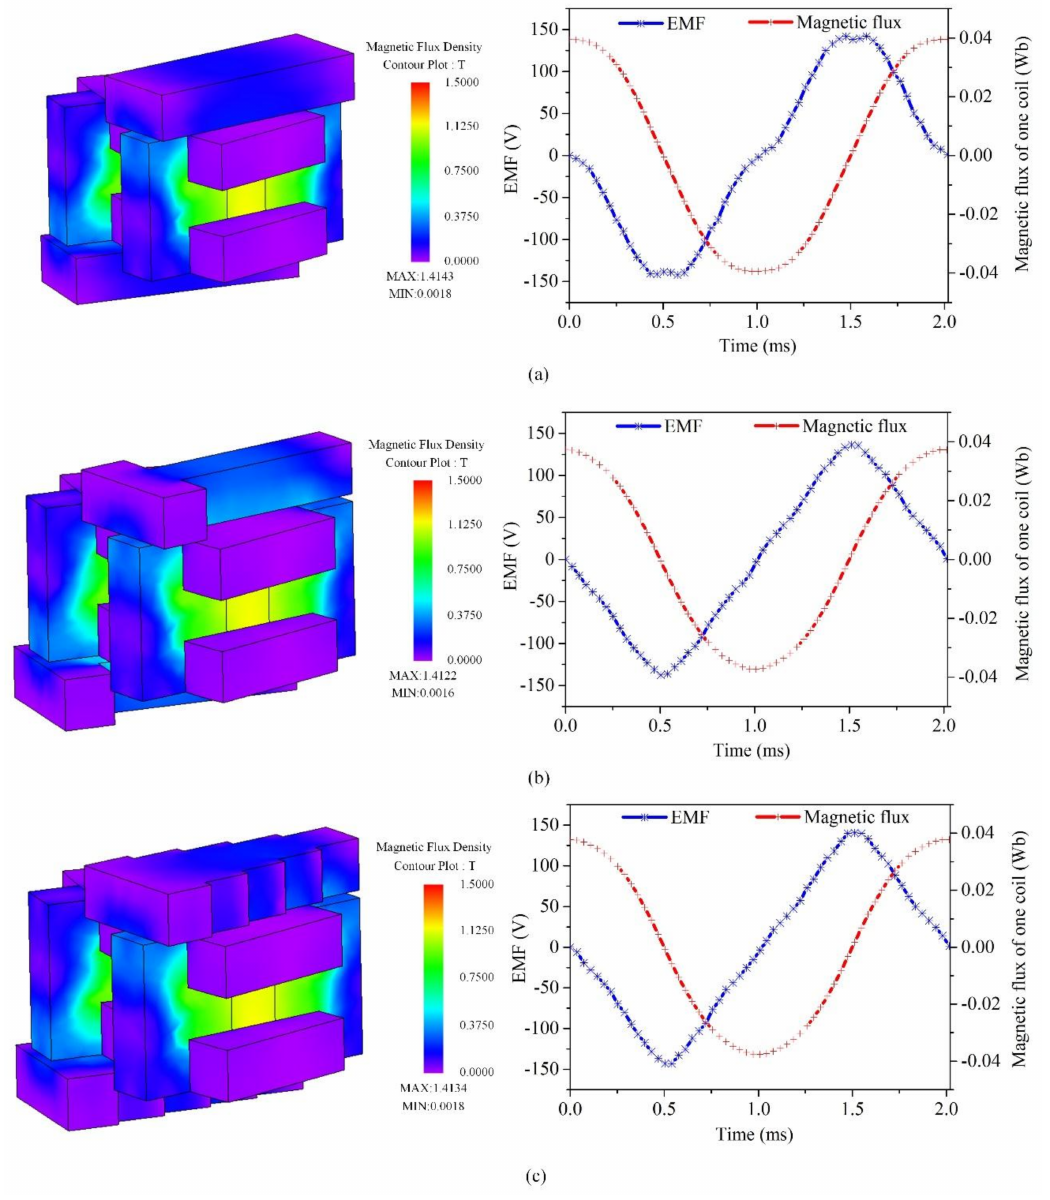
Figure 11. Magnetic field distribution and EMF of the three TFPMDGs with different rotor cores: ( a ) Wider “I” shape rotor core; ( b ) “T” shape rotor core; ( c ) Five-stair-step shape rotor